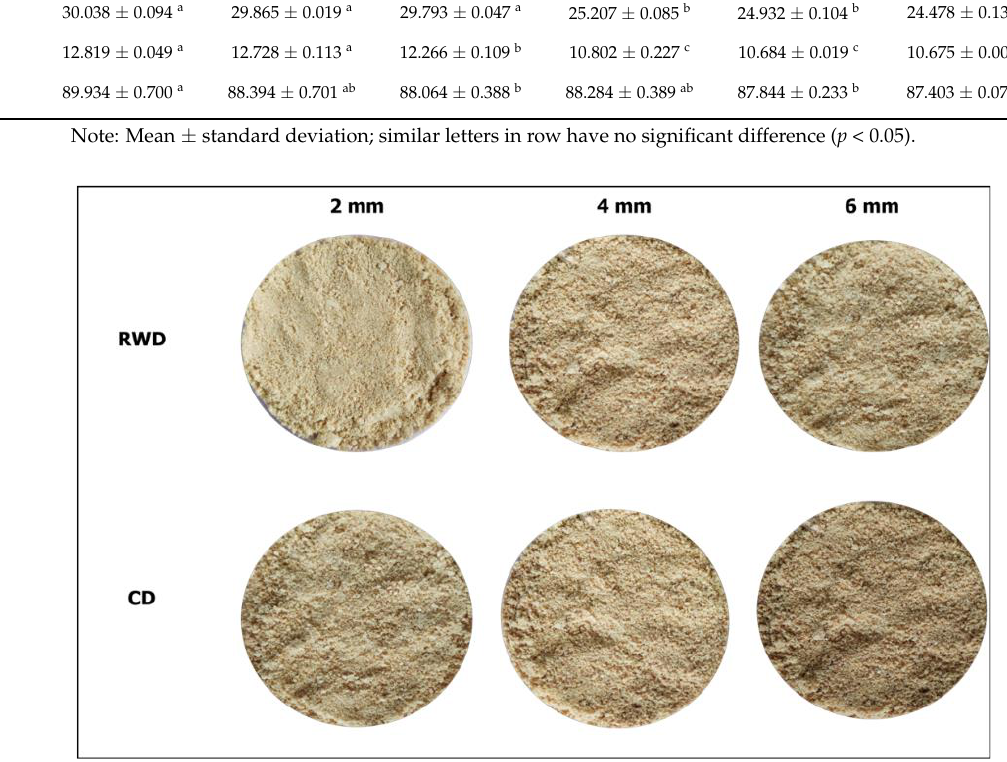
Figure 7. Onion powder samples obtained at varying thicknesses of puree.